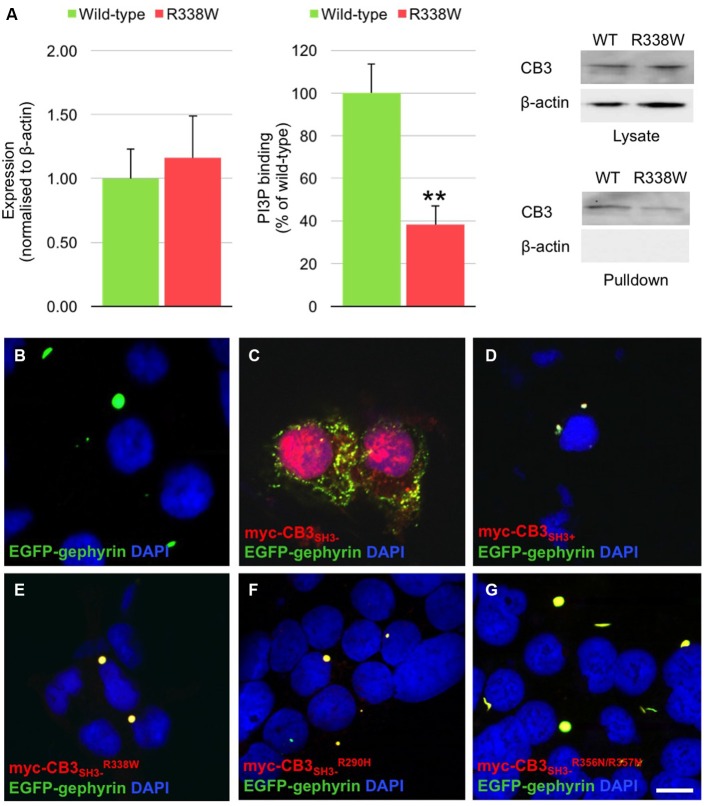
R338W reduces collybistin PI3P binding and prevents formation of collybistin-mediated submembrane gephyrin clusters in cellular assays. (A) Human embryonic kidney (HEK293) cells were transfected with plasmids encoding myc-CB3SH3− or myc-CB3SH3−R338W and cell lysates incubated with PI3P-conjugated agarose beads. After washing, bound material was subjected to SDS-PAGE and analyzed by immunoblotting with an anti-myc antibody (Sigma). Notably, no significant difference was observed in total level of myc-CB3SH3−R338W expression in comparison with wild-type CB3SH3−, using β-actin as a loading control (A, left and right panels, normalized to wild-type 1.00 ± 0.23 vs. R338W 1.16 ± 0.33; wild-type ± SEM, n = 5). myc-CB3SH3−R338W binding to PI3P was significantly reduced (62.7% ± 3.9%) in comparison to wild-type CB3SH3−. When we assessed the PI3P pull-down fraction as a percentage of the raw input, we saw a significant difference between wild-type and the R338W variant (A, middle and right panels; wild-type 100 ± 13.5 vs. R338W 38 ± 8.6; pull-down fraction ± SEM, n = 5, **p < 0.006, unpaired student’s t-test). No β-actin immunoreactivity was observed in PI3P pull-down samples, confirming the validity of this assay. (B–G) HEK293 cells were co-transfected with EGFP-gephyrin alone (B), or with myc-CB3SH3−
(C), myc-CB3SH3+
(D), myc-CB3SH3−R338W
(E), or the PI3P binding defective mutants myc-CB3SH3−R290H
(F), and myc-CB3SH3−R356N/R357N
(G). Cells were immunostained using anti-myc and AlexaFluor 546 antibodies and co-stained with a nuclear marker (DAPI). Note that while myc-CB3SH3− co-localizes with gephyrin in submembrane clusters, all other CB variants co-localize with gephyrin in large intracellular aggregates, consistent with a lack of CB-mediated gephyrin clustering activity. Scale bar = 10 μm. (C) is a Z-projection, all other images are single plane.